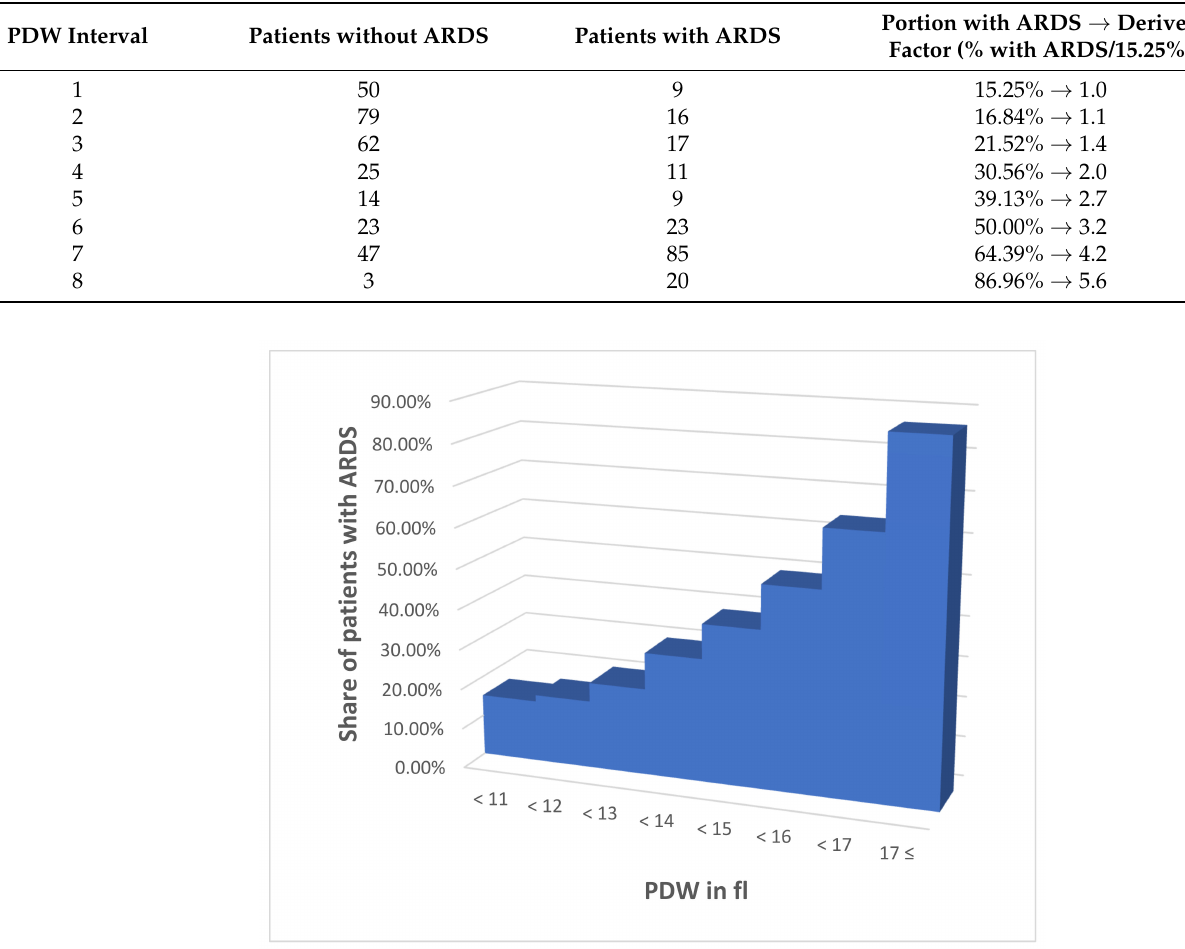
Figure 1. Frequency of development of ARDS in respective PDW intervals.